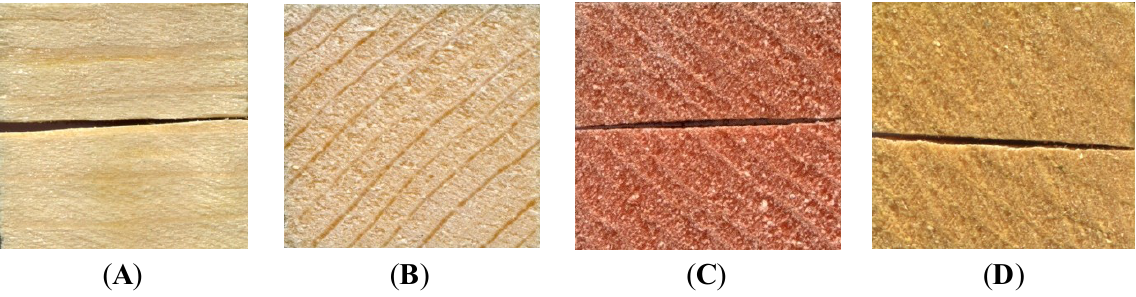
Figure 2. Coloring of external surface of test blocks from liquid cultures. ( A ) lodgepole pine with no treatment; ( B ) lodgepole pine with C. aeruginosa ; ( C ) lodgepole pine with S. cuboideum ; ( D ) lodgepole pine with S.